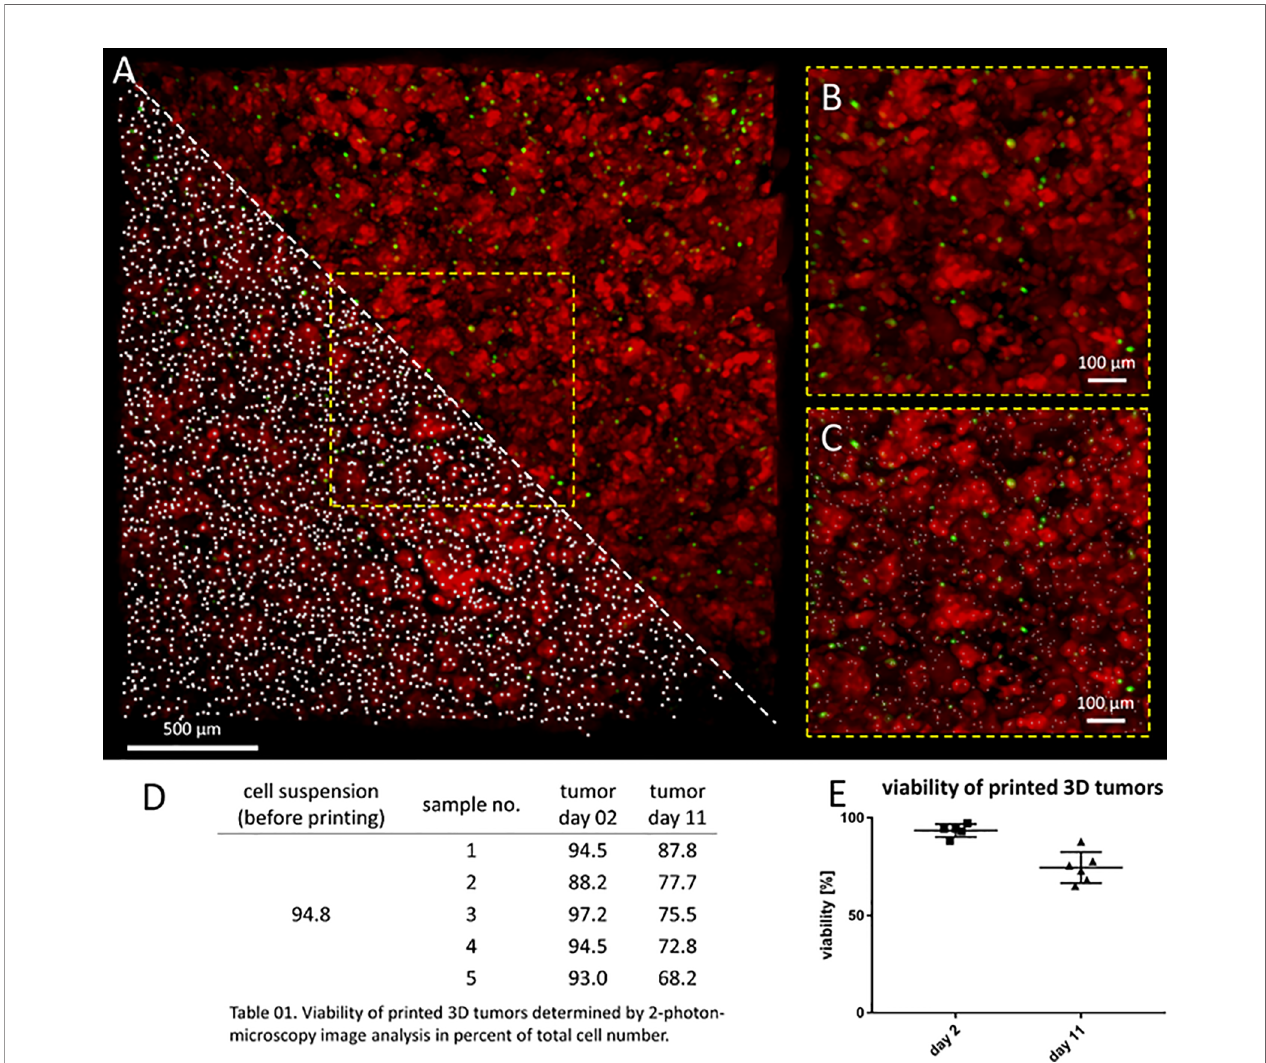
FIGURE 2 | Neuroblastoma cells remain viable over 11 days in bioprinted 3D tumor model. (A) Image shows 0.75mm³ cut-out of bioprinted 3D tumor model, which was visualized by 2-photon image analysis. Viable cells are stained by CellTracker TM red and dead cells by CellTox TM green. A region of interest is enlarged without marking cells (upper triangle and B ) and by computationally counting cells visualized by white dots (lower triangle and C ) Scale bar = 100 μm. Neuroblastoma cell viability both before and after printing is presented in the table (D) and graph (E) . Viability of printed cells after 2 days and 11 days in culture was determined by 2- photon image